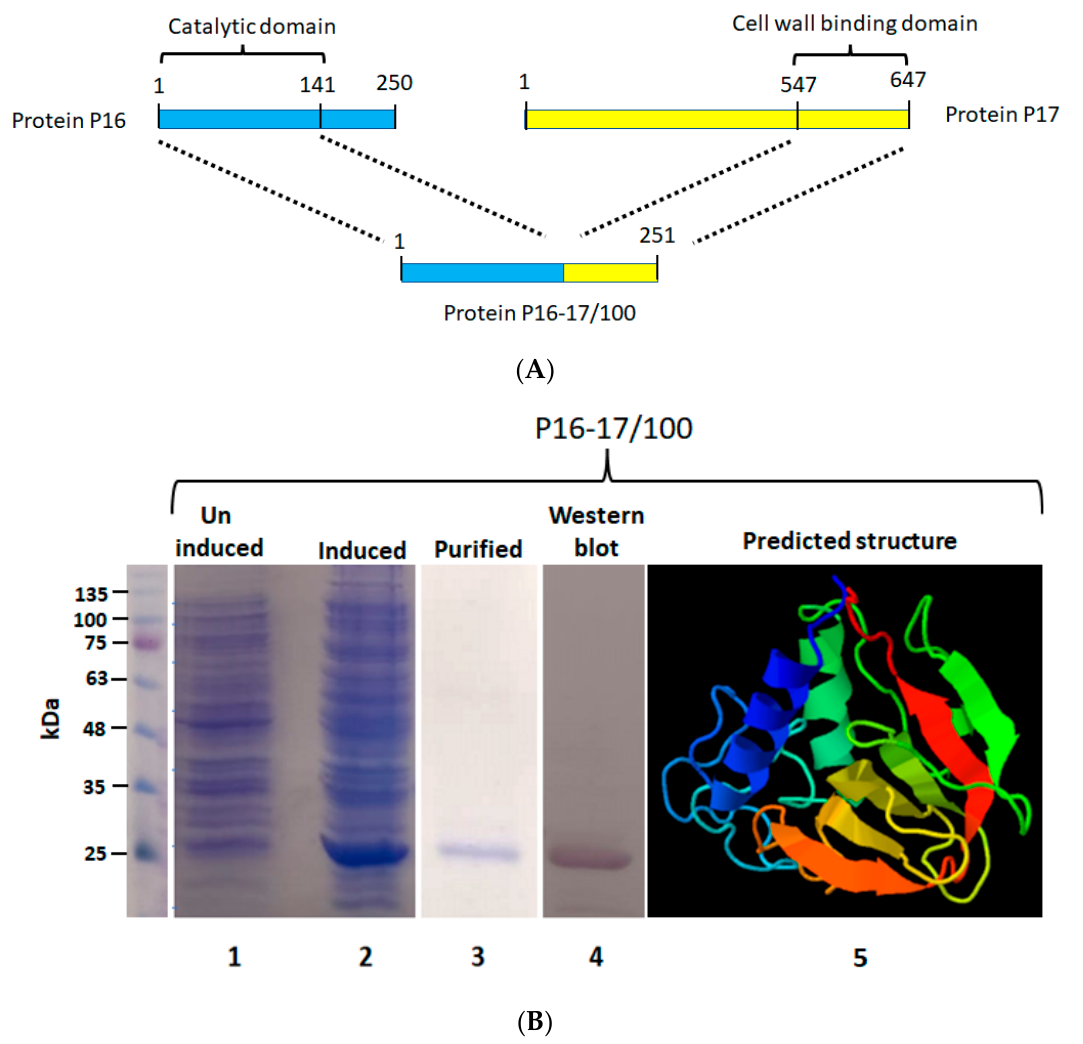
Figure 1. Construction of protein P16-17/100. ( A ) The catalytic domain from protein P16 (141 aa) was linked to the cell wall binding domain of protein P17 (100 aa). ( B ) Expression and purification of protein P16-17/100. Lane 1 shows the uninduced culture without synthesis of the protein. The induced culture showing synthesis of protein P16-17/100 is shown in lane 2. The Ni-NTA-purified protein is shown in lane 3. The Western blot performed to detect the protein is shown in lane 4. The structure of P16-17 predicted by the Phyre program is shown in lane 5. Violet to Red (rainbow colors) change represents N-terminal to C-terminal domain of the protein